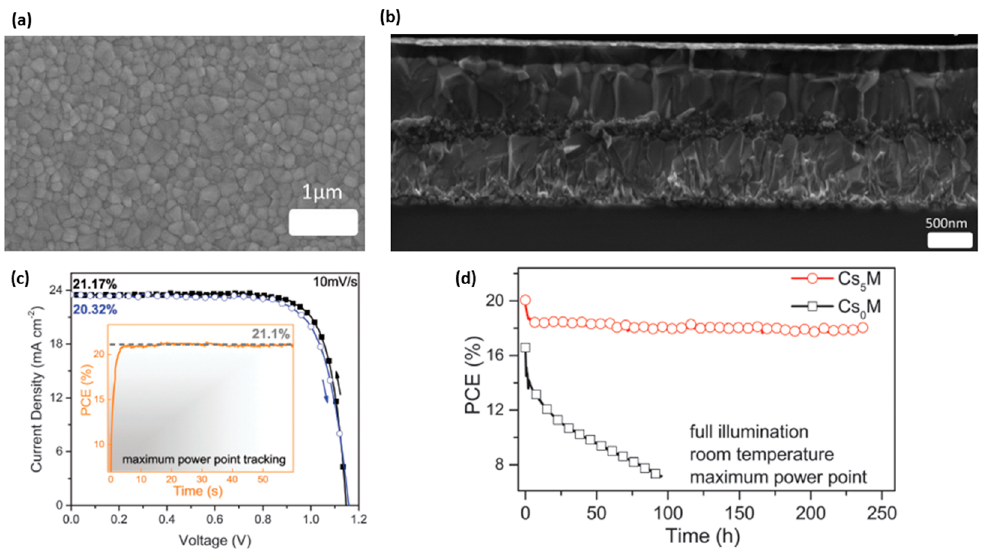
Figure 6. ( a ) Top ( b ) and cross-sectional view scanning electron microscope (SEM) images of the Cs-doped FAMA perovskite films and the whole meso n-i-p devices, respectively. ( c ) Forward and reverse scanned J-V curves under 1 sun illumination and stabilized output power characteristics recorded for 60 s. ( d ) Aging for 250 h of devices with (Cs 5 M) or without Cs + (Cs 0 M) in a nitrogen atmosphere held at room temperature under constant illumination and maximum power point tracking [45]. Published by The Royal Society of Chemistry.